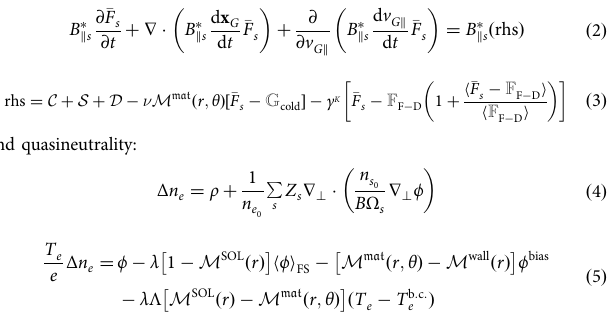
equations for the guiding-centre distribution function (cid:1) F s of ion species s , evolved with no separation between equilibrium and perturbation in fi ve-dimensional guiding-centre space ( x G , v G ∥ , μ ) and time. In Eq. (3), 〈 ⋅ 〉 = ∫ J v J x ⋅ d v ∥ d μ d θ d φ , with J v and J